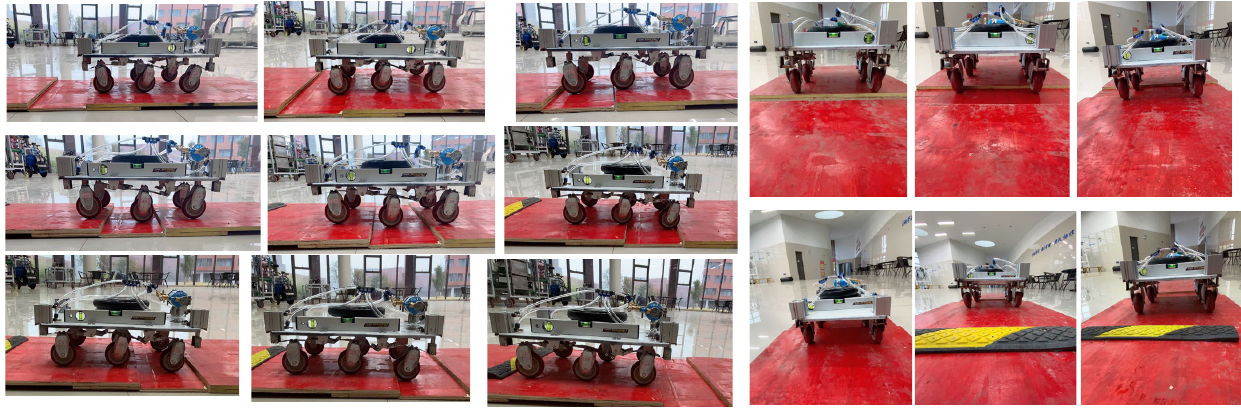
Figure 19. Crossing trench tests in ( a ) longitudinal direction and ( b ) transverse directions.